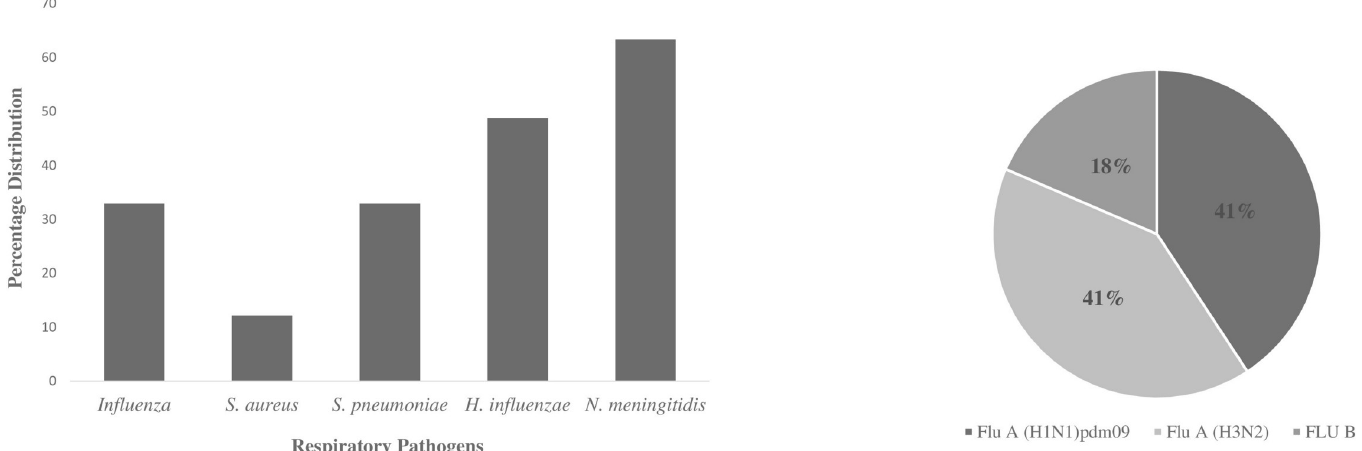
Fig 2. a. Prevalence of respiratory pathogens detected among the cohort. Study population size (82); Influenza positive samples were cultured on MDCK cell line for virus isolation before molecular detection by Real-Time RT PCR. b. Percentage distribution of Influenza virus types detected among the cohort. The presence of single and multiple pathogens were evaluated among the cohort during treatment (Fig 3A). Of the 82 eligible participants, single pathogens were detected in 21(25.61%) of cohort and multiple pathogens in exactly 50% (41) of the cohort. The multiple infections included 22 (26.83%) double, 14 (17.07%) triple and 5 (6.10%) quadruple infections. About 24.39% (20) of the cohort had no pathogen present during the study even though some presented with ARI-like symptoms during treatment (Fig 3A). H . influenzae and N . meningitidis were more commonly identified with all other pathogens (Table 3). Influenza and bacterial co-infection was also observed among 34.15% of the cohort during treatment (Fig 3B), a combination of influenza and at least one of the bacterial pathogens with the exception of S . aureus